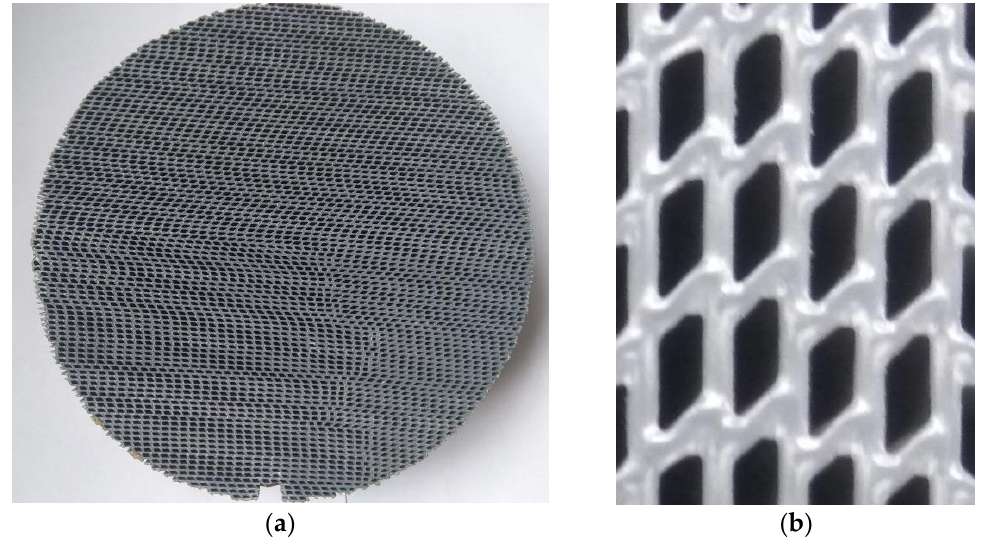
Figure 5. Cross-section (the end) of the UVRK-50 nozzle ( a ) and a scaled-up image of the cross-section of several channels ( b ).